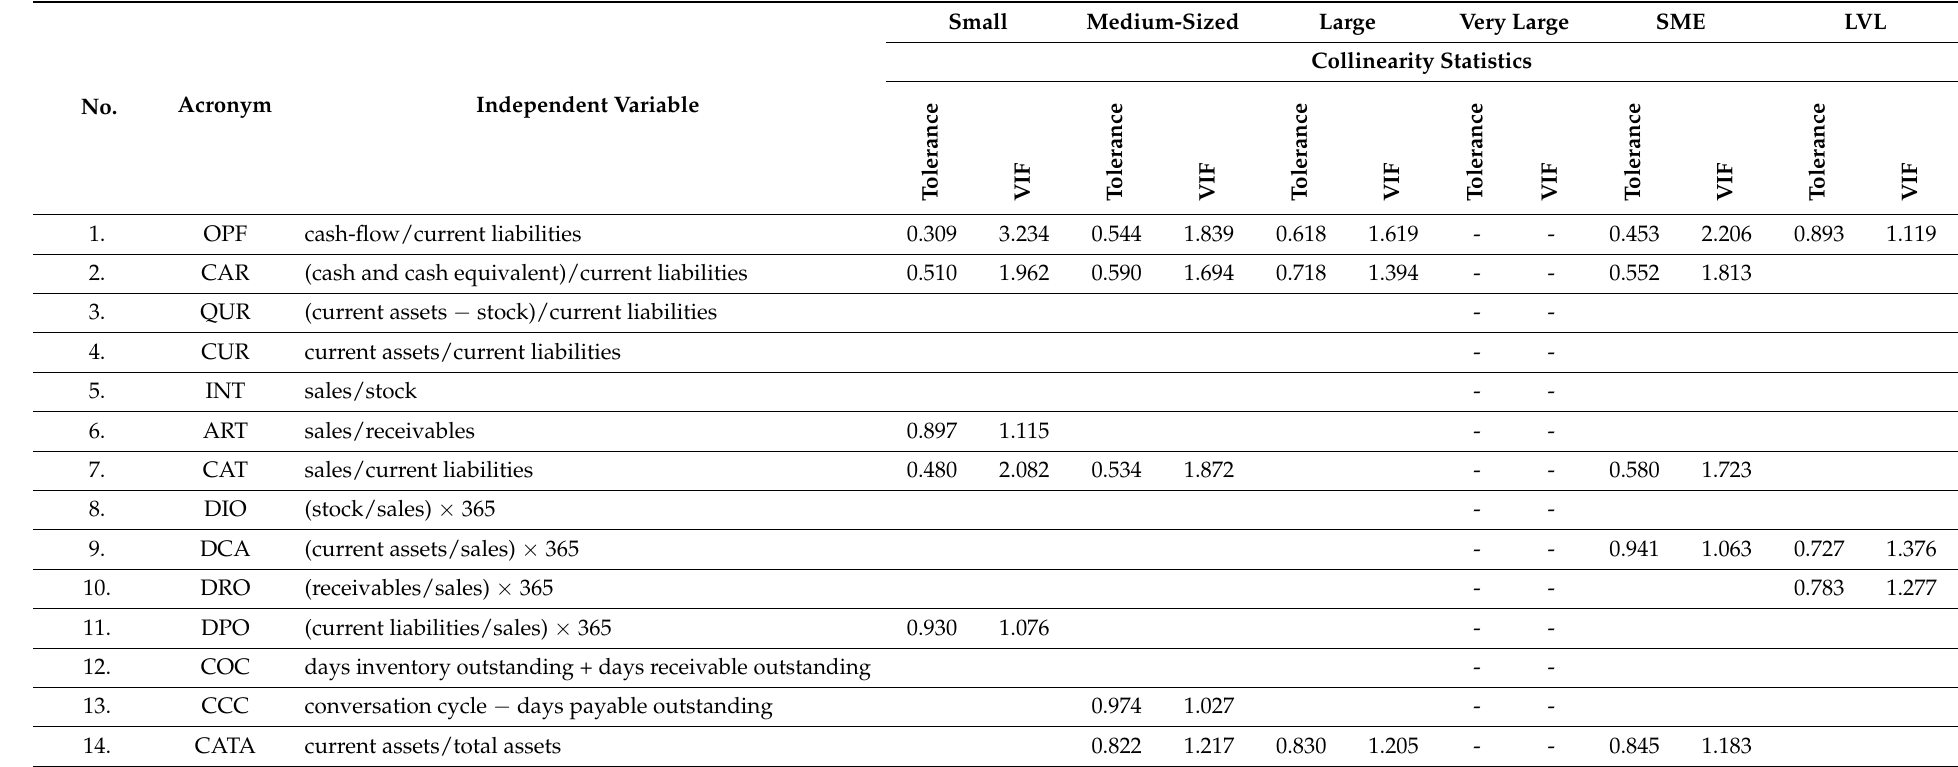
Table A2. VIF for the selected subsamples in the Slovak